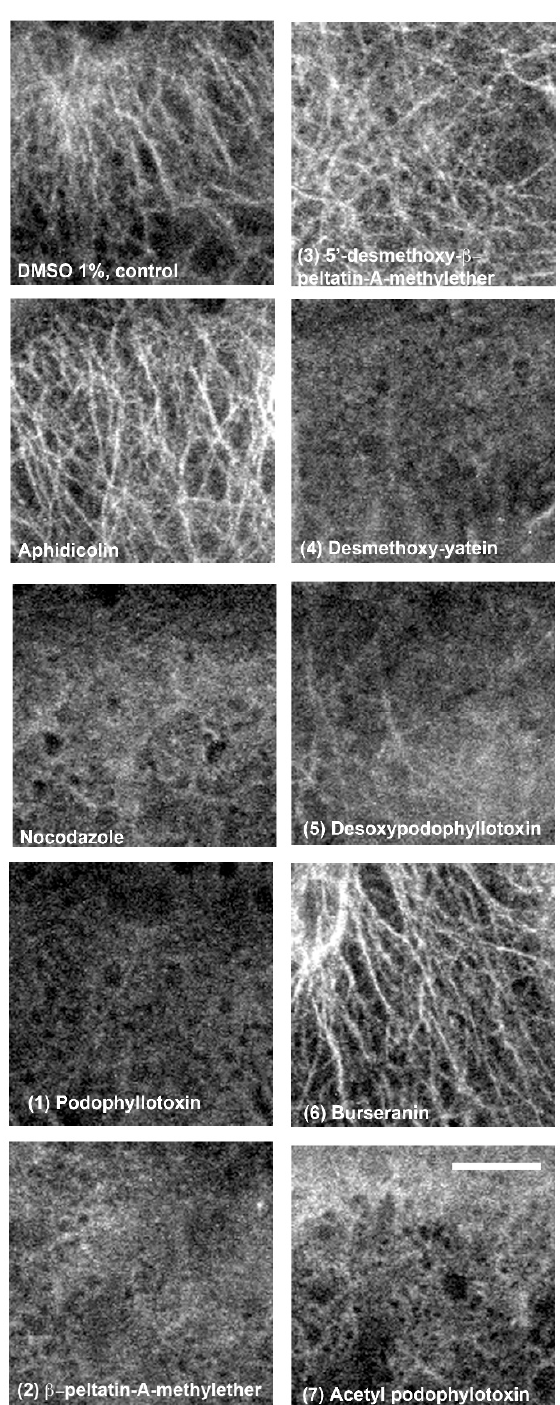
Figure 5. Whole-mount immunolocalization of yolk cell microtubules in zebrafish embryos after treatment with lignans ( 1 )–( 7 ). Sphere-stage zebrafish embryos were treated with different compounds until all embryos reached 50% epiboly; they were then fixed, processed for microtubule fluorescent immunolocalization, and visualized by confocal microscopy. Scale bar, 25 μ m.